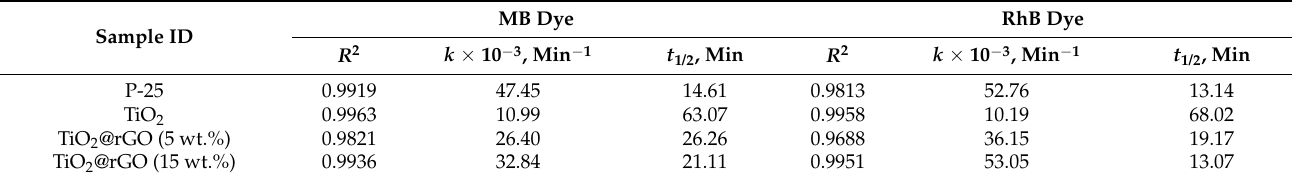
Figure 9. The percentage of ( A ) MB and ( B ) RhB degradation efficiency by the photocatalytic activity of the prepared catalysts under the radiation; rate constant, k of ( C ) MB and ( D ) RhB degradation for the as-prepared photocatalysts. Table 2. Photodegradation kinetics of MB and RhB dyes under